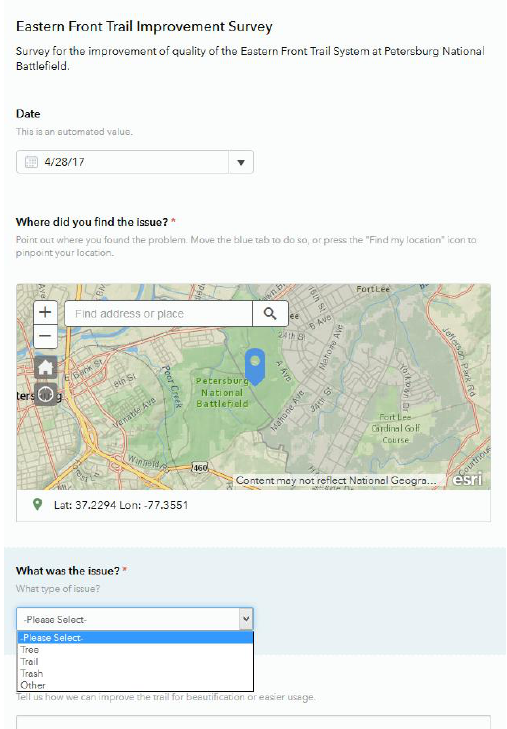
Figure 5. Eastern Front Trail Improvement Form (https://survey123.arcgis.com/share/ ae80624007cc4635a6e03c704ef0707a).